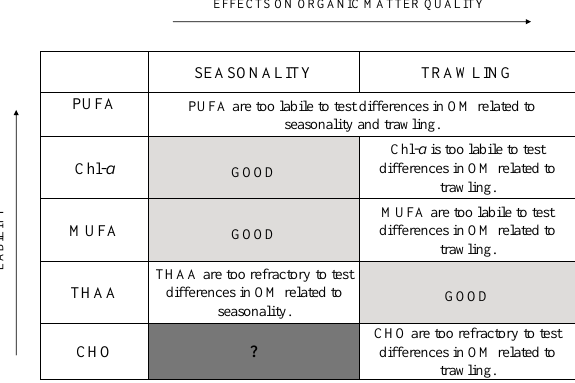
Fig. 3. Schematic representation of the results obtained in this study by using a pool of biomarkers with different lability to investigate on the effects of seasonality and sediment reworking by trawling on the quality of the OM. Due to the unavailability of spring samples, we did not test differences in CHO between